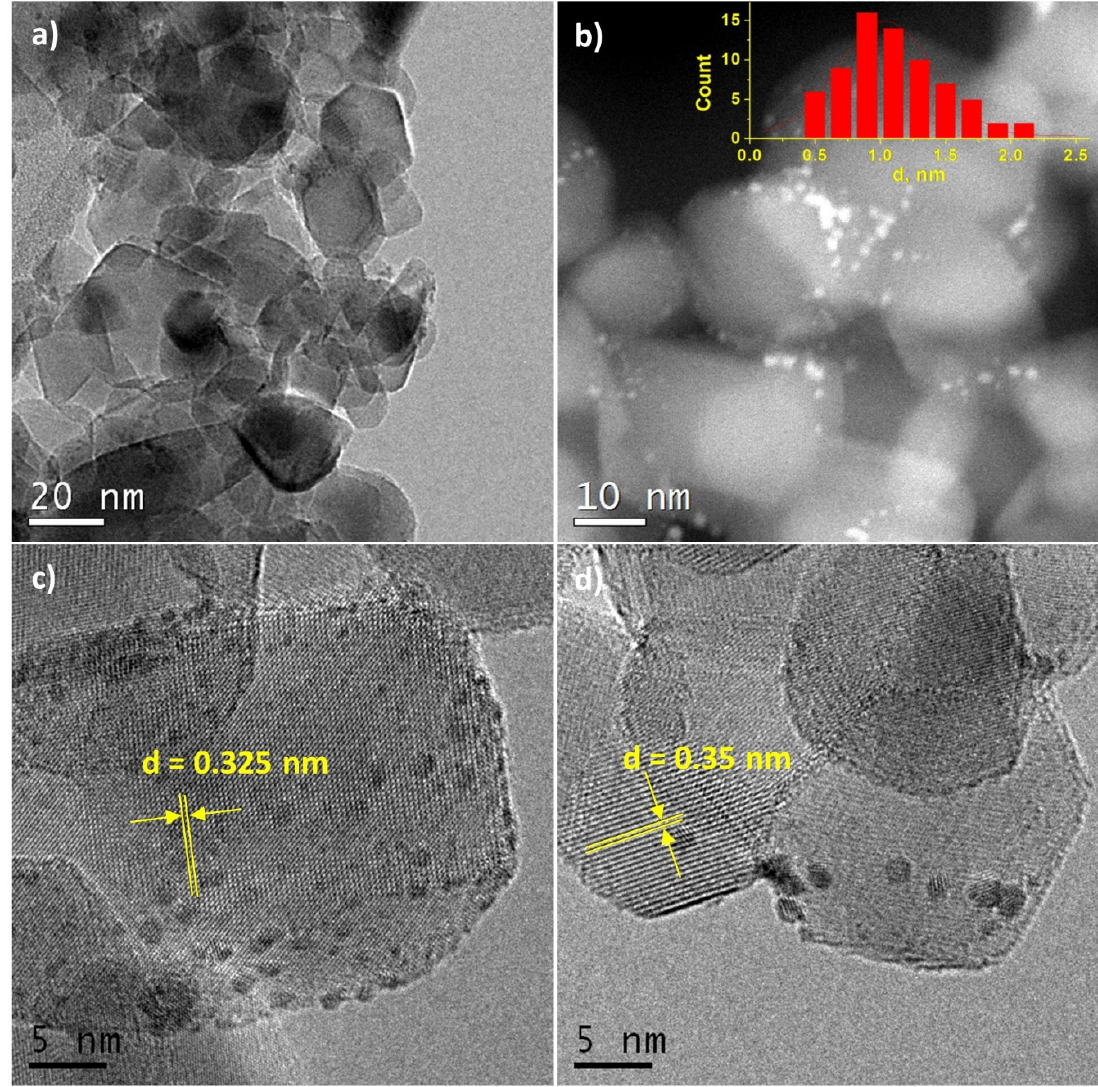
Figure 3. ( a,c,d ) High-resolution transmission electron microscopy (HRTEM) and ( b ) high-angle annular dark-field imaging scanning transmission electron microscopy (HAADF-STEM) images for Pt/Ti-P25-400 sample. The inset shows the size distribution of platinum particles.